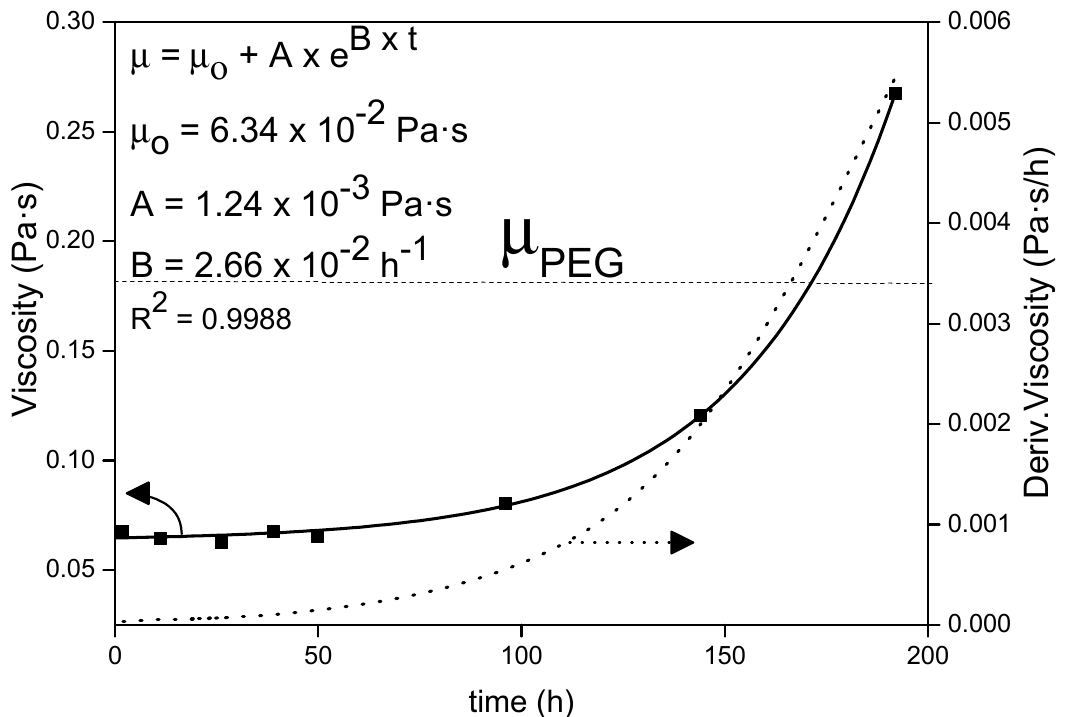
Figure 2. Evolution of the sol viscosity with time.